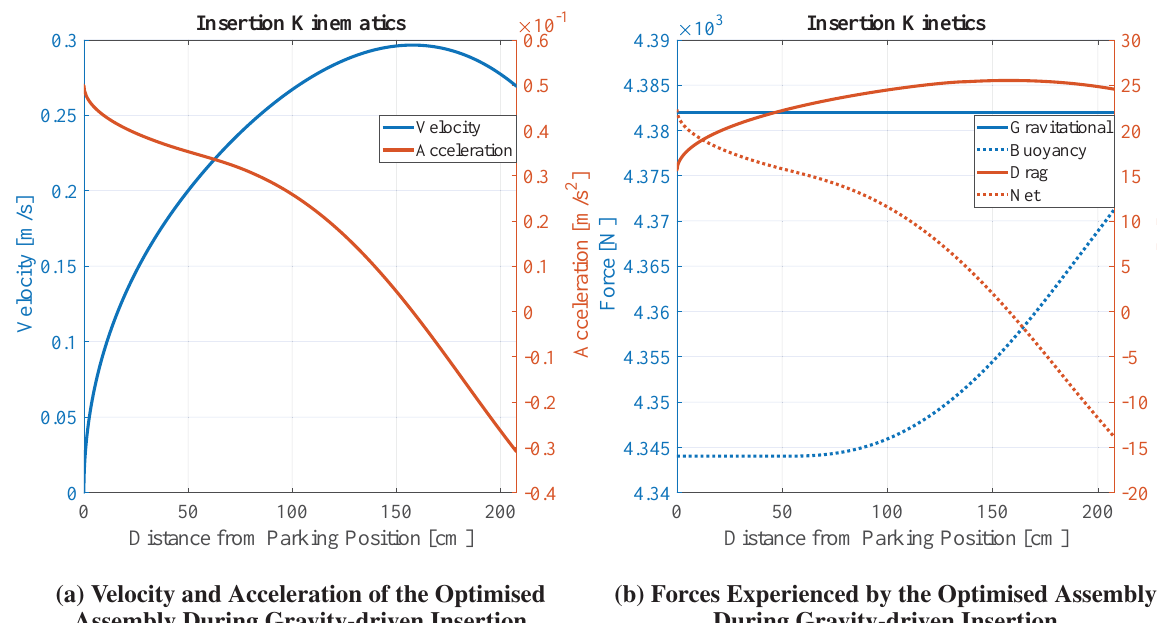
Figure 4: Dynamical Parameters During Passive Gravity-driven Insertion in the